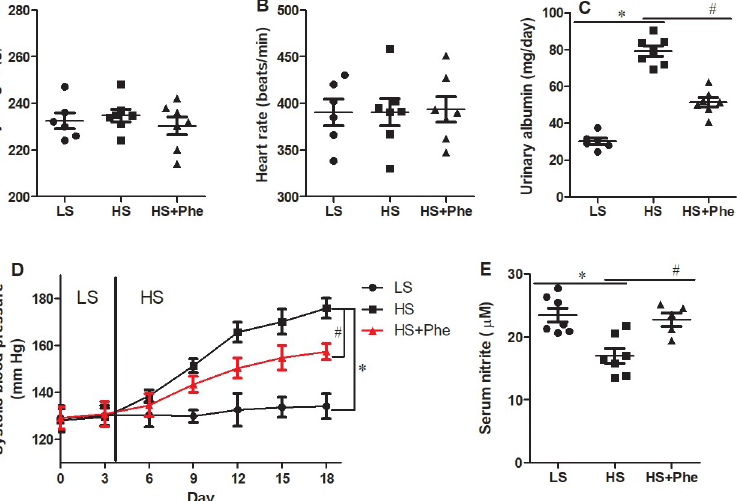
Fig 2. Effects of phenylalanine supplementation on body weight (A), heart rate (B), systolic pressure (C), serum nitrite (D), and urinary albumin (E) in Dahl SS rats fed a low salt or high salt diet. Each value represents the mean ± SEM, n = 6–8, � p < 0.05 vs. LS group, # p < 0.05 vs. HS